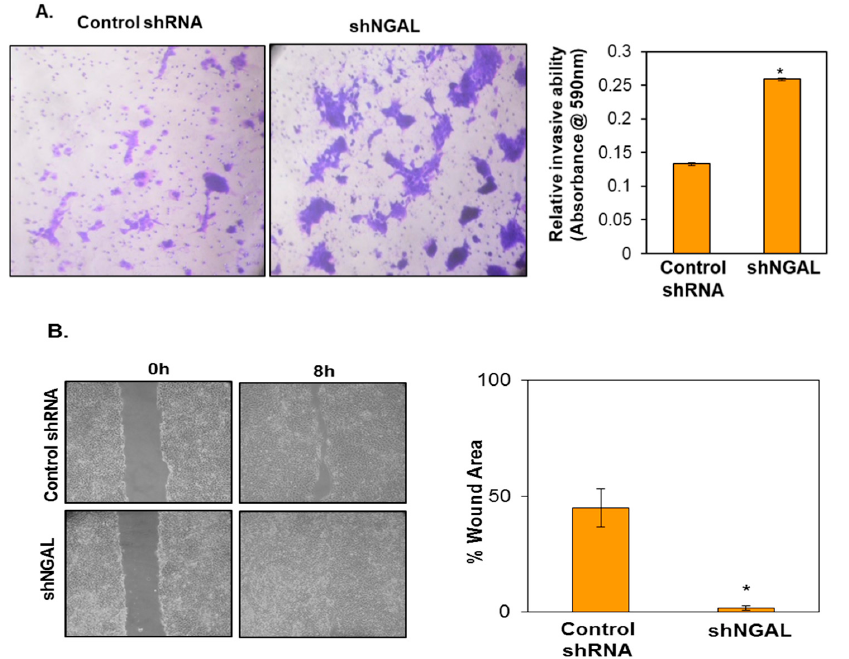
Figure 4. Silencing of NGAL increased the invasion and migration of oral cancer cells. ( A ) Cell invasion was determined by a transwell invasion assay. Cells invading through the matrigel were fixed, stained, and photographed under an inverted microscope at a 20 × magnification. Graphical representation of increase in cells invading the lower surface of transwell insert (right panel). ( B ) Cell migration was detected by scratch wound healing assay. Photographs were taken at 10 × magnification. Graphical representation of decrease in wound area (right panel). Data are means ± SE. * = p < 0.05 ( n = 4).